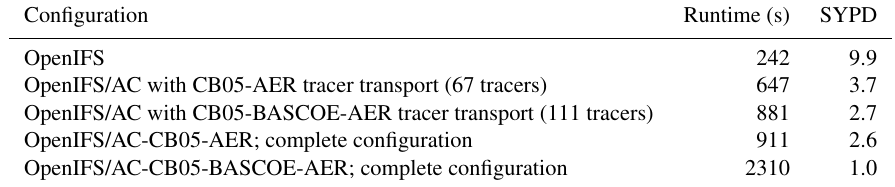
Table 4. Computational costs for various OpenIFS/AC configurations to run a 10d nudging experiment on T L 255, 91 model levels, on 288 CPUs, using different configurations of OpenIFS and OpenIFS/AC. Costs are given in terms of runtime and model simulation years per day (SYPD).